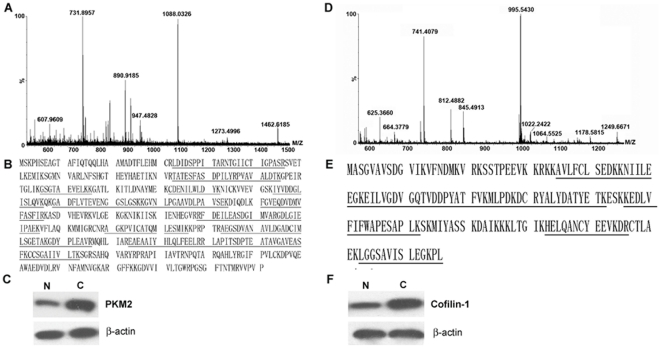
ESI-Q-TOF MS/MS identification and western blot validation of representative proteins PKM2 and cofilin-1.(A & D). Mass spectrogram of tryptic peptides of PKM2 and cofilin-1. (B & E). Protein sequence of PKM2 and cofilin-1. The matched peptides are underlined. (C & F). Western blot validation of PKM2 and cofilin-1 with pooled clinical samples. N: normal tissues; C: lung adenocarcinoma tissue.